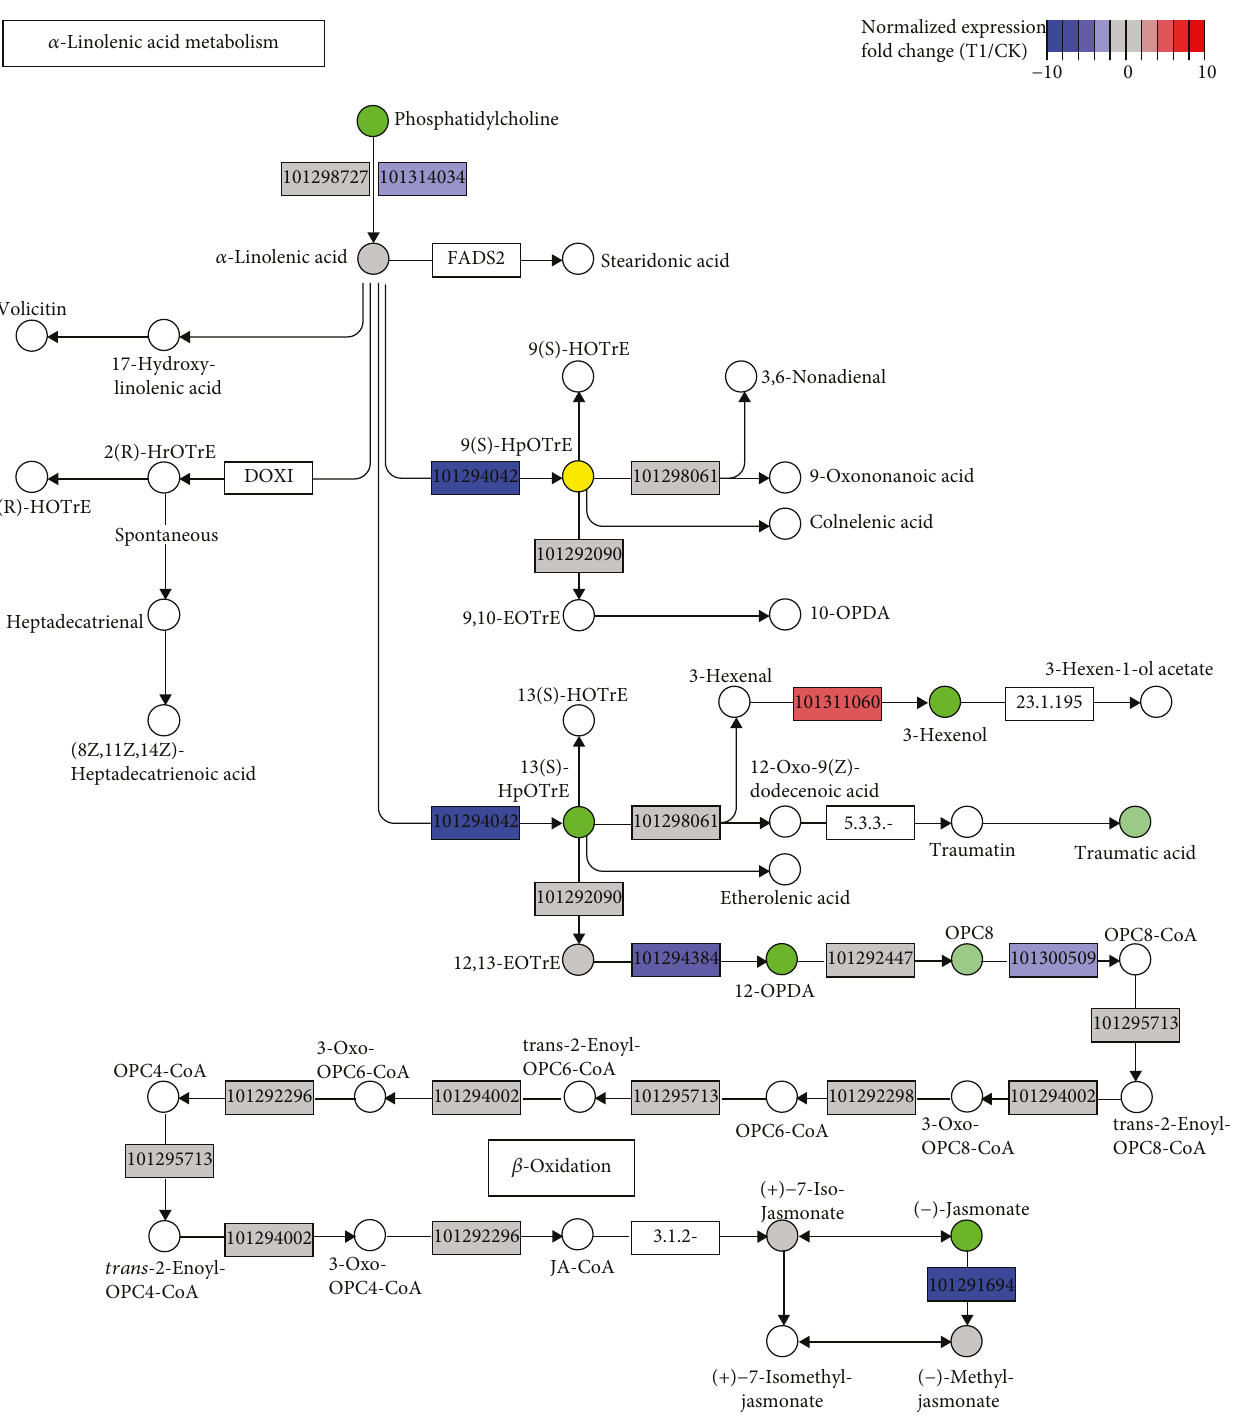
Figure 7: α -Linolenic acid metabolism pathways mapped with relative expression levels (T1 vs . CK). Gene ID of F. vesca is indicated at the corresponding gene node if there